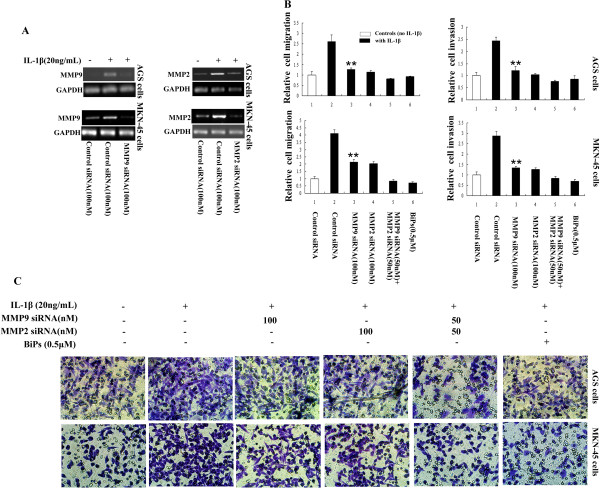
Knockdown of MMP2 or MMP9 or pretreatment with the MMP2/9 inhibitor BiPs inhibits IL-1β-induced GA cell migration and invasion in vitro. A: RT-PCR confirmed the efficiency of the MMP2 or MMP9 siRNAs, which significantly reduced MMP2 or MMP9 expression, respectively, by up to more than 75%. B: IL-1β increased GA cell migration and invasion in vitro; these effects were inhibited by MMP2 or MMP9 siRNA or the MMP2/9 inhibitor BiPs. **P < 0.05 vs. scramble siRNA (control siRNA)-transfected cells stimulated with IL-1β. Bars are the mean ± SD fold changes normalized to control group in the migration and invasion assays. C: Representative light microscopy images of AGS and MKN-45 cell migration and invasion in the Transwell migration and invasion assays.